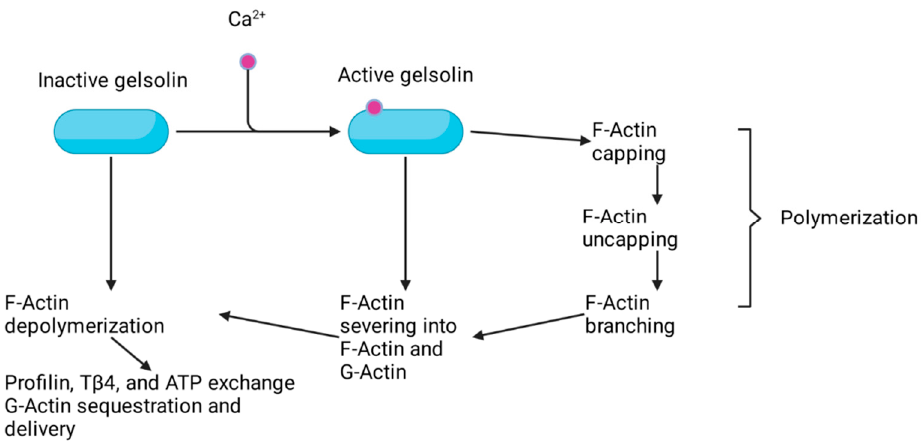
Figure 3. Overview of gelsolin activation through calcium binding and roles in modulating actin structural changes.